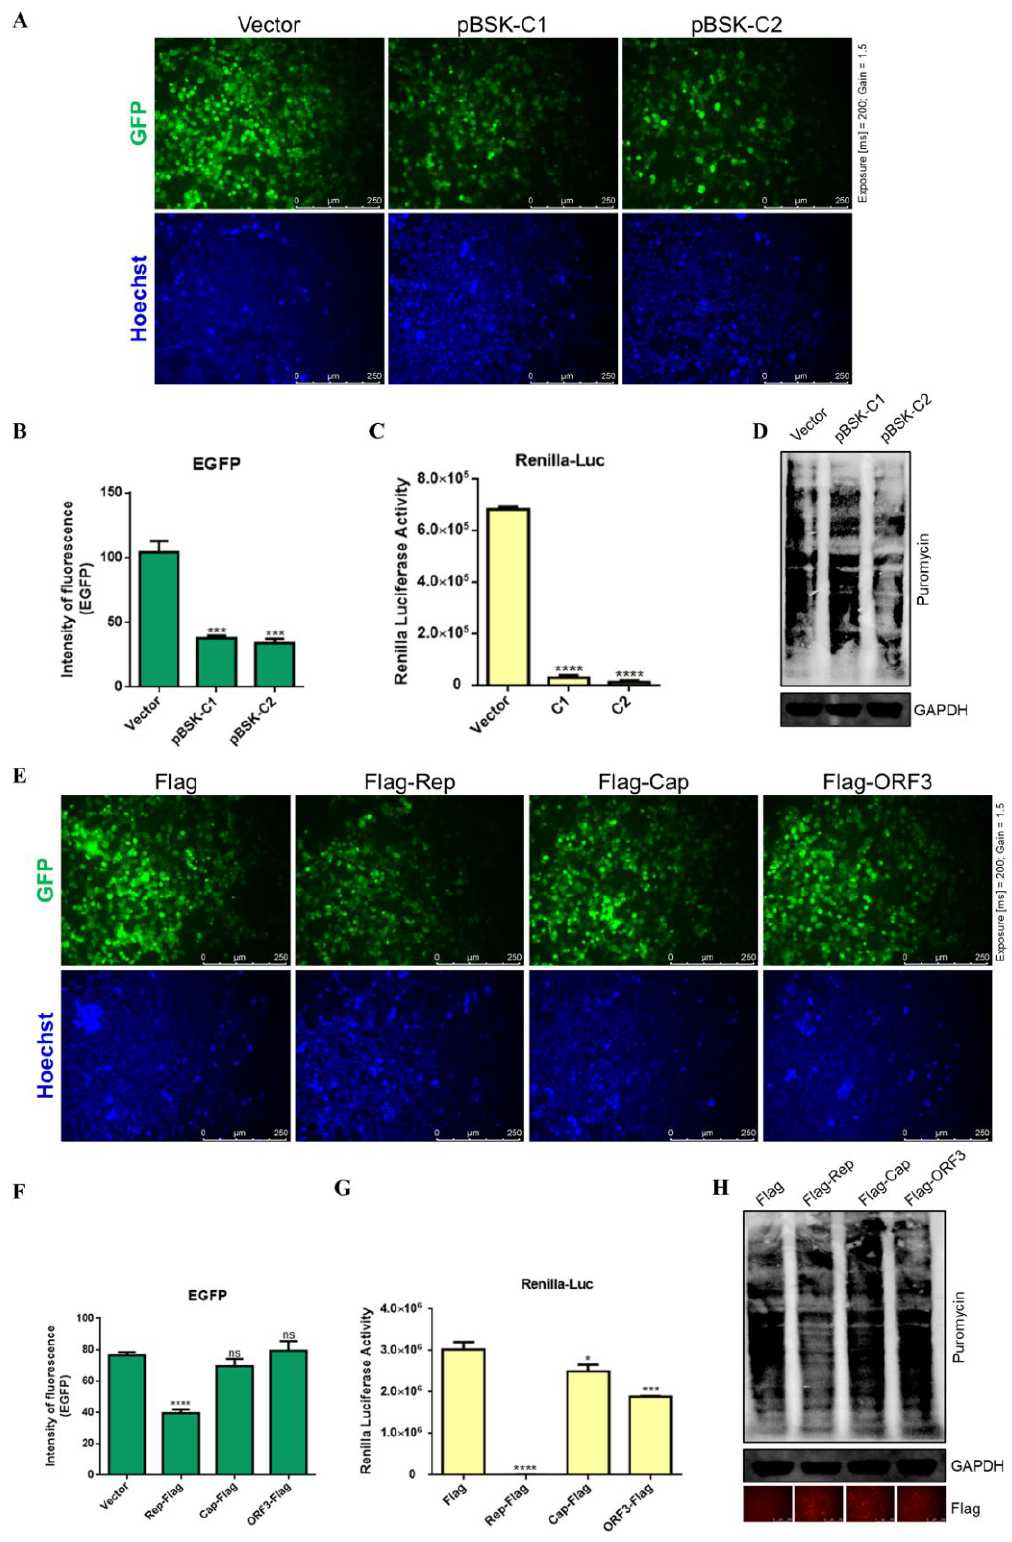
Figure 4. CanineCV and Rep inhibited protein expression. ( A , E ) F81 cells were cotransfected with EGFP-tagged protein expression plasmids and different viral plasmids. After 48 h, the cells were imaged under a fluorescence microscope (Exposure [ms] = 200; Gain = 1.5), and the fluorescence intensity, indicating the level of protein expression, was calculated using ImageJ ( B , F ). The results suggest that CanineCV and the Rep protein affected the expression of EGFP. ( C , G ) F81 cells were cotransfected with the pRL-TK plasmid and different viral plasmids. After 48 h, the cells were col- lected and Renilla luciferase activity was measured. Luciferase activity indirectly reflects the level of protein expression in cells. ( D , H ) Forty-eight hours after transfection, puromycin (10 μg /mL) was added to the medium and incubated at 37 °C for 30 min. The cells were washed twice with PBS and then lysed for WB analysis. Nascent peptides labeled with puromycin were detected with an anti-puromycin monoclonal antibody. An anti-Flag antibody was used to confirm viral protein